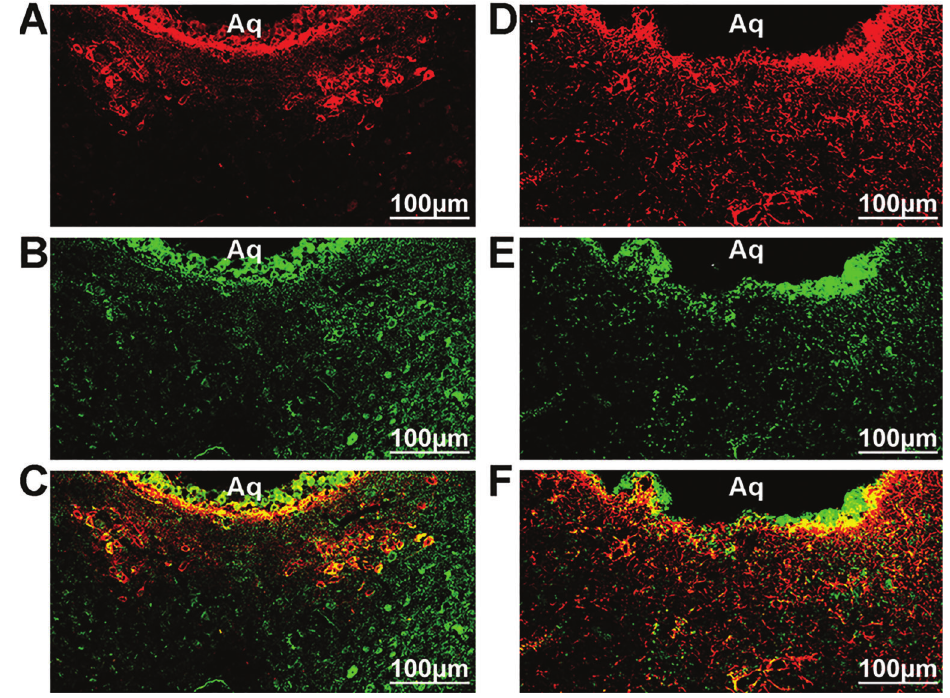
Figure 2. Expression of fractalkine (FKN) and CX3CR1 in the CSF-contacting nucleus. A - C , Cholera toxin subunit B-labeled positive neurons (red) and FKN-immunoreactive neurons (green) were co-expressed in speci fi c neurons (yellow in merged image). D – F , Colocalization of Iba-1 (red) and CX3CR1 (green) immunoreactivity (yellow in merged image). n=3 per group, Scale bar =100 m m. Aq: aqueduct. CSF: cerebrospinal fl uid.